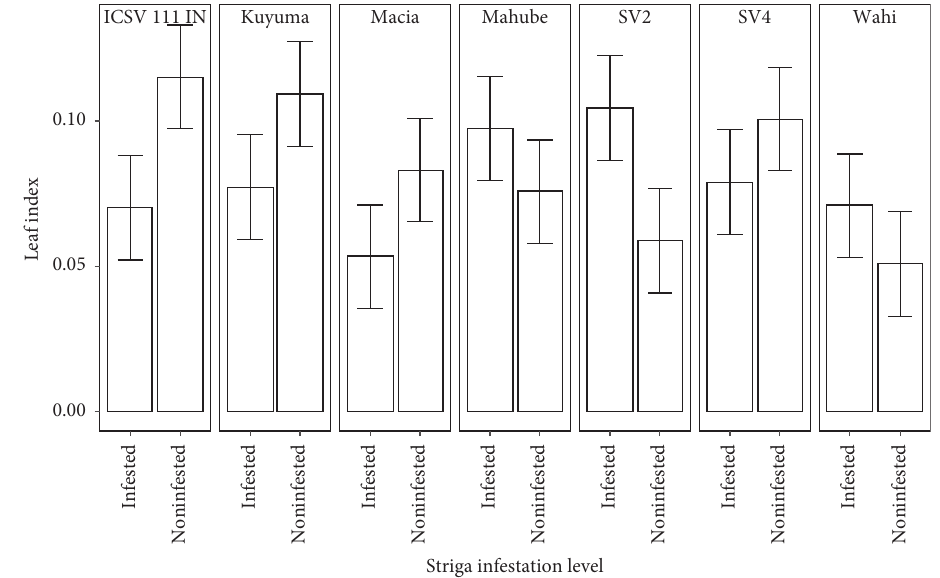
Figure 6: Effect of genotype and Striga interaction on sorghum leaf index. Error bars represent LSD at p < 0 . 05.